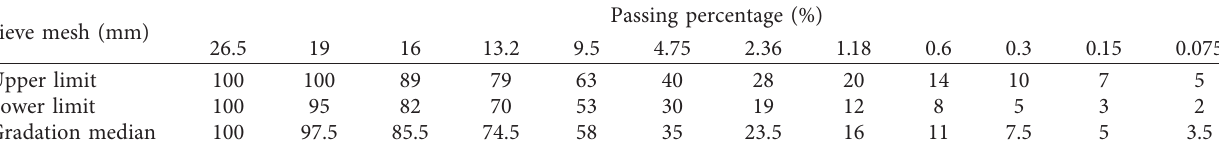
Table 5: Gradation range of G-A-5 grading macadam for the upper base.